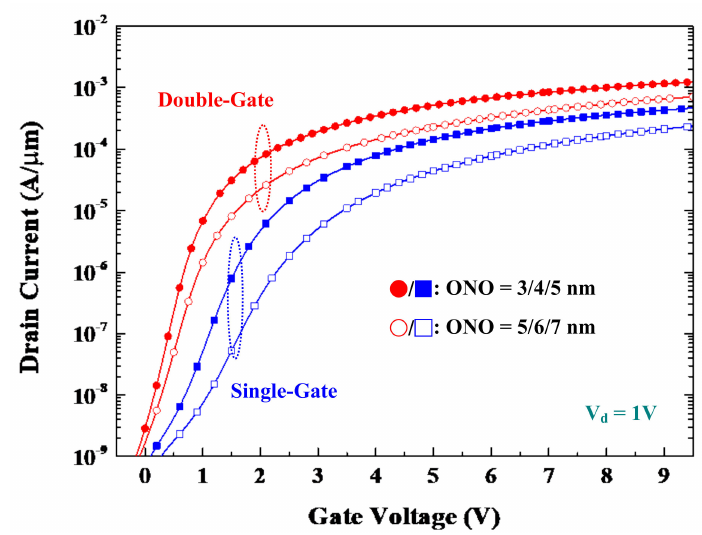
Figure 2. Simulated drain currents of single- and double-gate Schottky barrier charge-trapping cells with multi-ONO layers of 5 / 6 / 7 and 3 / 4 / 5 nm at a reading drain voltage of 1 V.